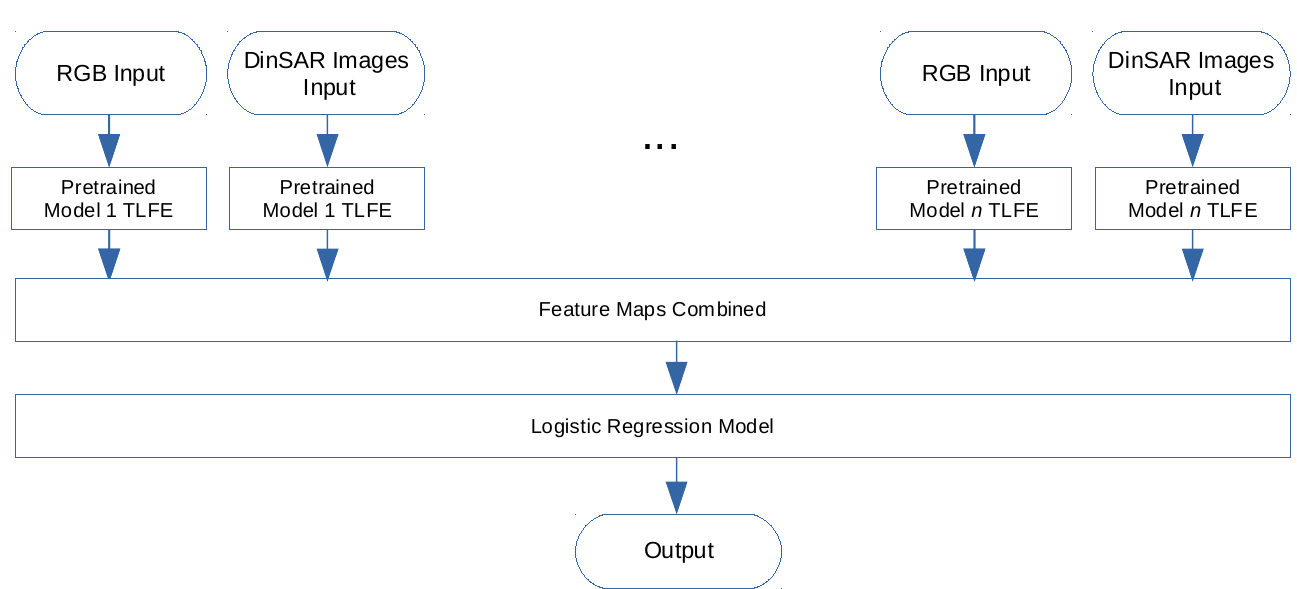
Figure 2. General form of the architecture of the FeatSpaceEnsNet family of transfer learning by feature extraction neural networks.